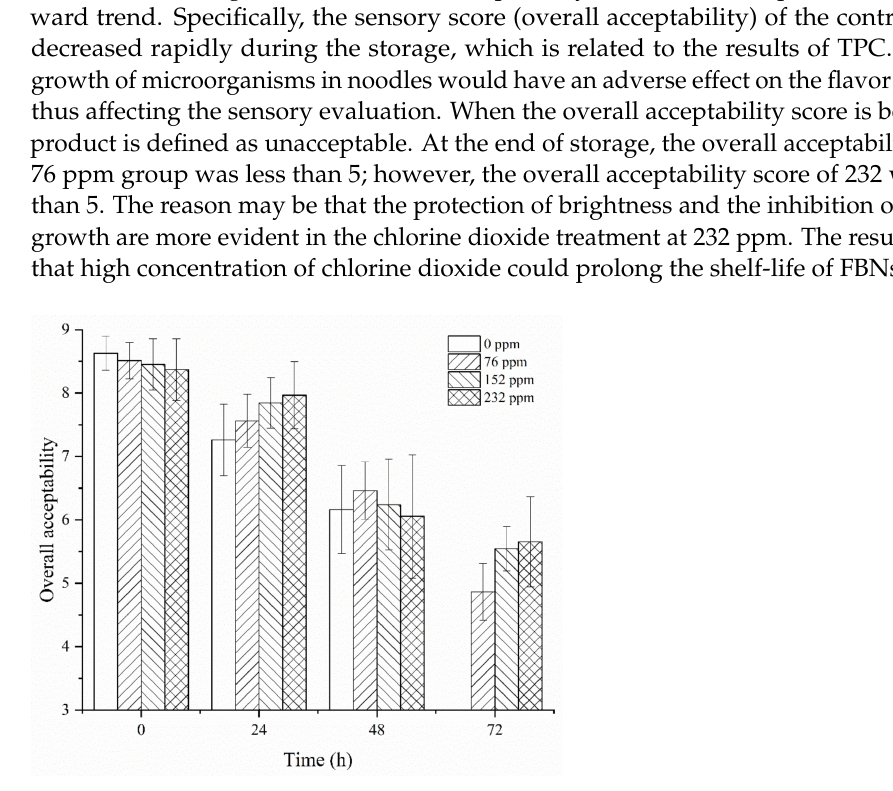
Figure 4. Overall acceptability of uncooked FBNs made from CDBF at different treatment concentra- tion during